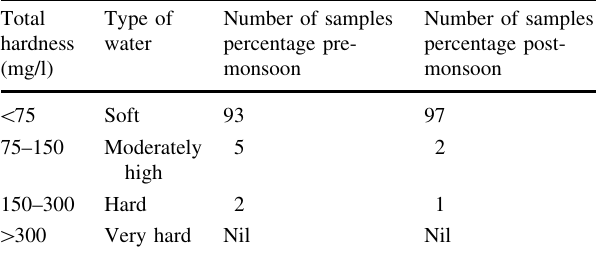
Table 4 Classification of groundwater based on total hardness (mg/ L) (Sawyer and McCarty 1967)